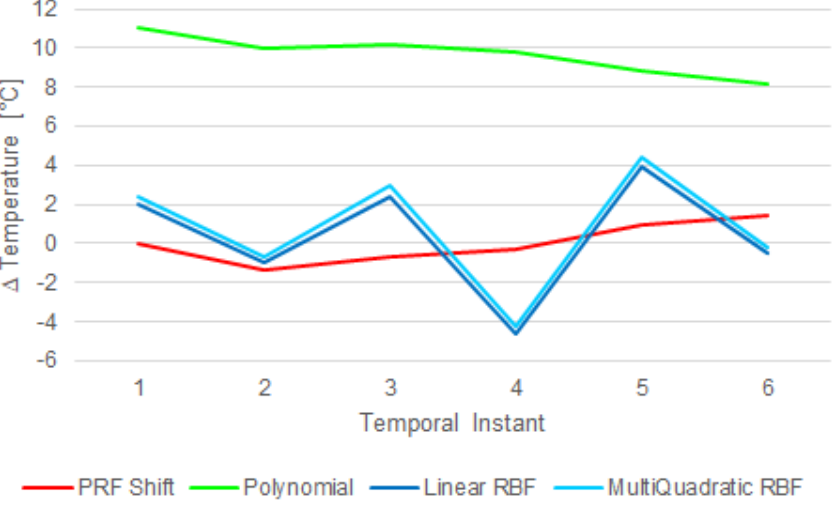
Figure 11. The interpolated temperature errors compared to PRF-based temperature measurements (which does not show any significant temperature rise). The polynomial (green) line overestimated